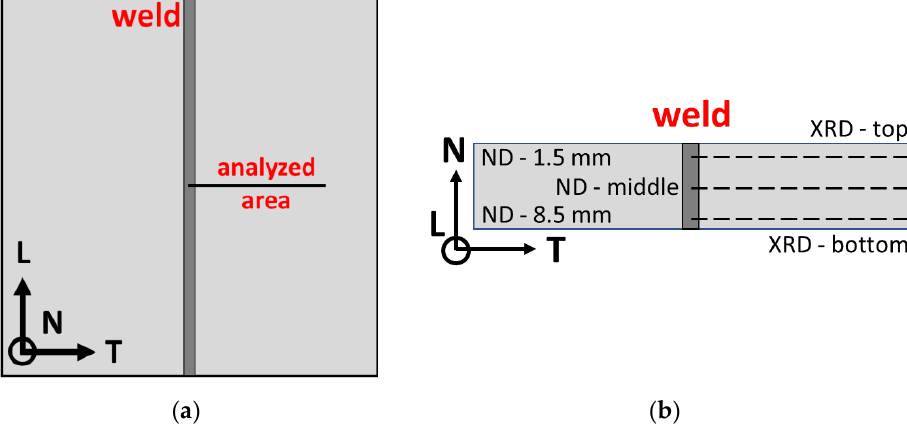
Figure 1. ( a ) Scheme of the sample and ( b ) scheme of marking the depths at which the residual stresses were determined by X-ray (XRD) and neutron (ND) diffraction.